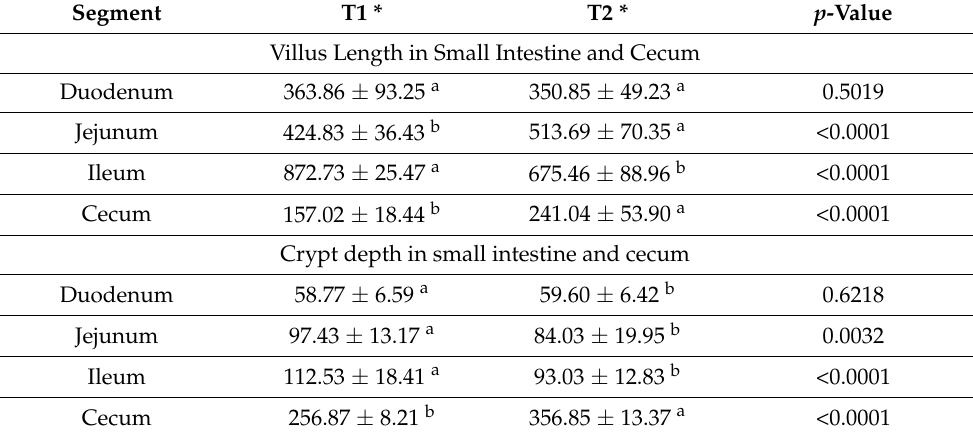
Table 4. Small intestinal and cecal morphology of rabbits fed with diets containing untreated sorghum (T1) and sorghum transformed by dual SSF with T. maxima CU1 and P. sanguineus CS2